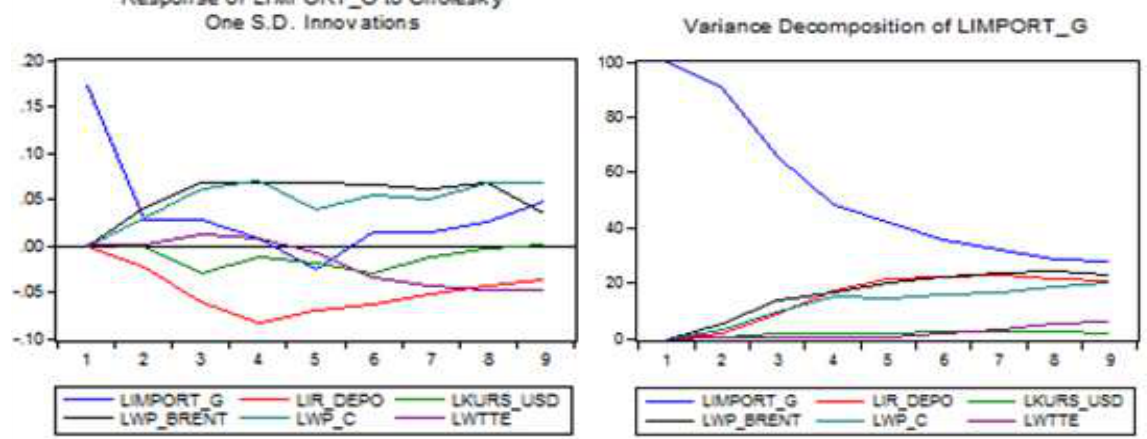
Fig. 7. The function of impulse responsesand the graph of goods import decomposition in Sumy region